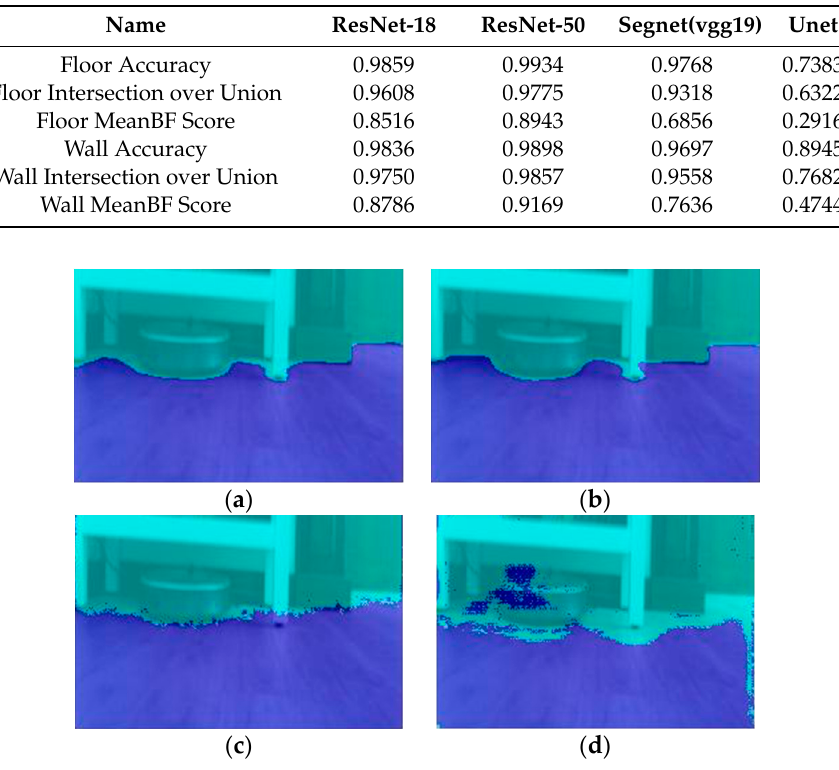
Figure 20. Testing image to view the net results: (a) ResNet-18 Results; (b) ResNet-50 Results; (c) Segnet (vgg19) Results; (d) Unet Results.